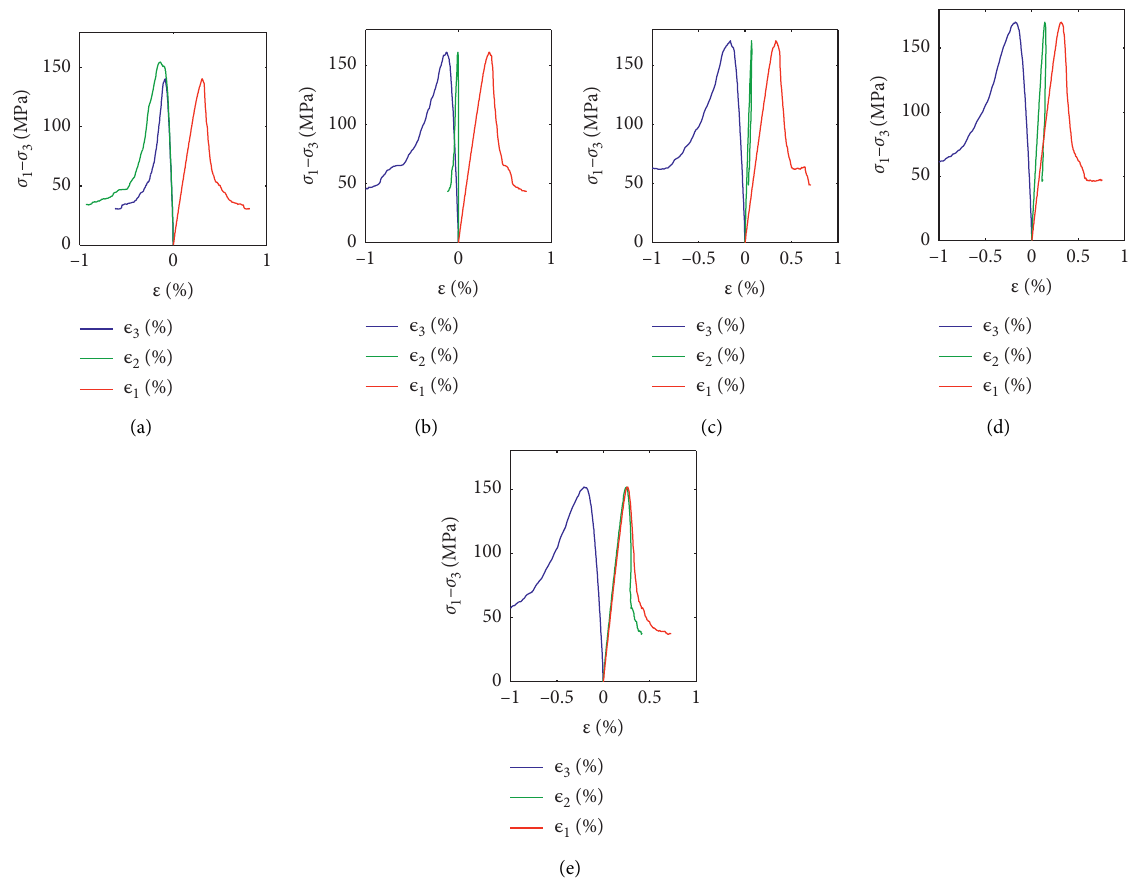
Figure 6: Deviator stress-strain curves in three directions. (a) b � 0, (b) b � 0.2, (c) b � 0.4, (d) b � 0.8, and (e) b �